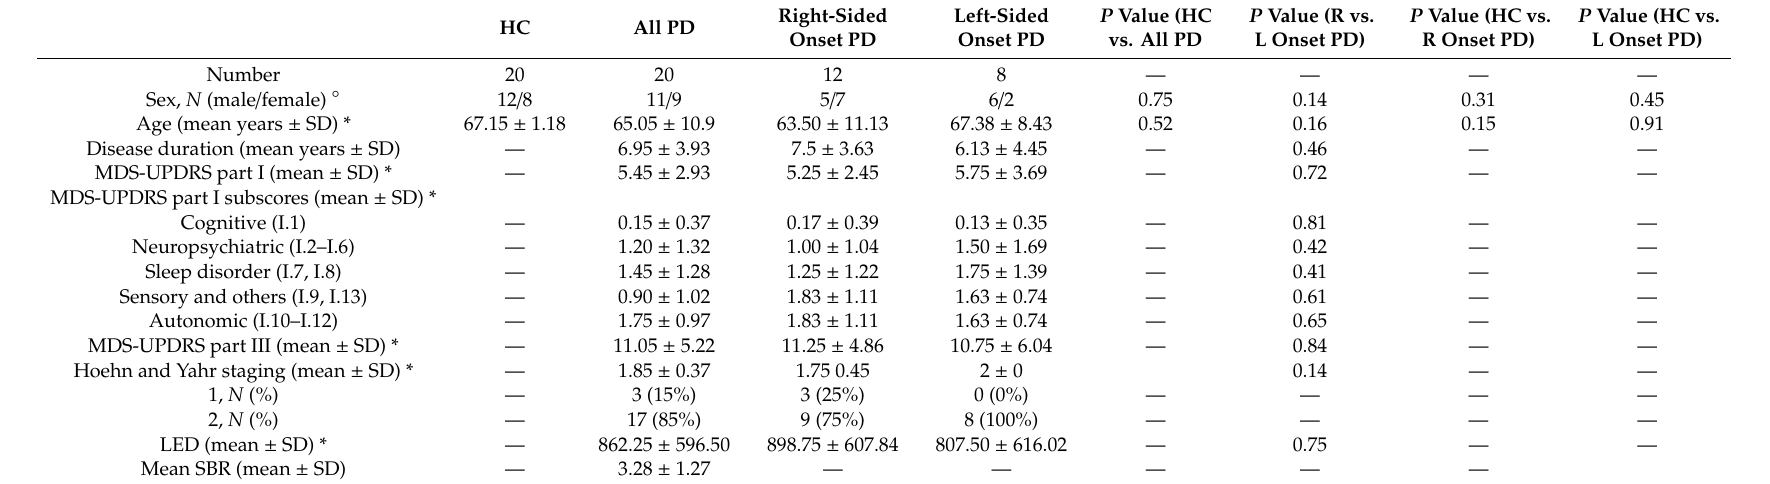
Table 1. Demographic characteristics of the study